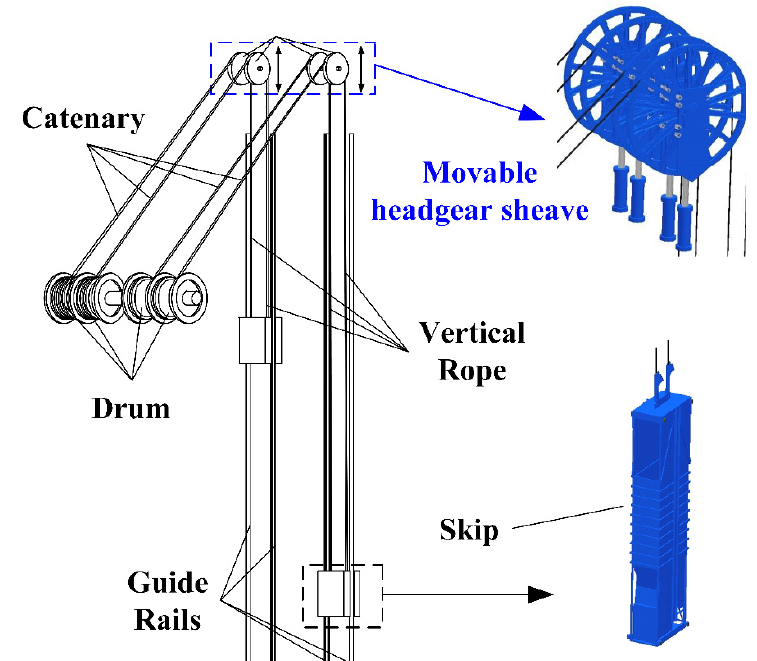
Figure 1. The structure of Blair mine hoist.